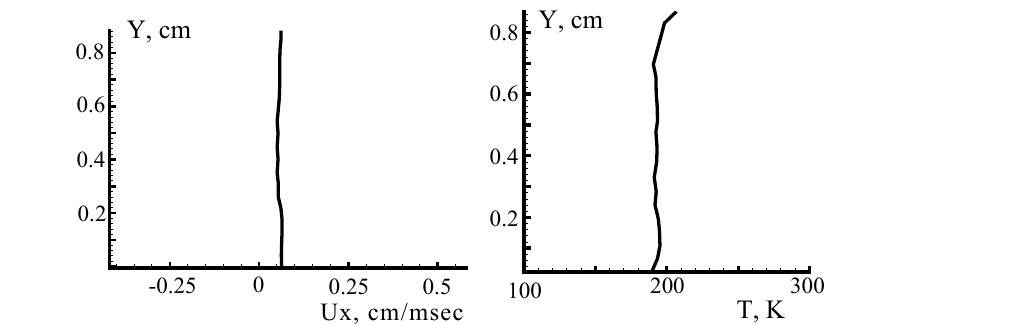
Figure 18: Distributions of the longitudinal velocity detonation velocity = 3 D